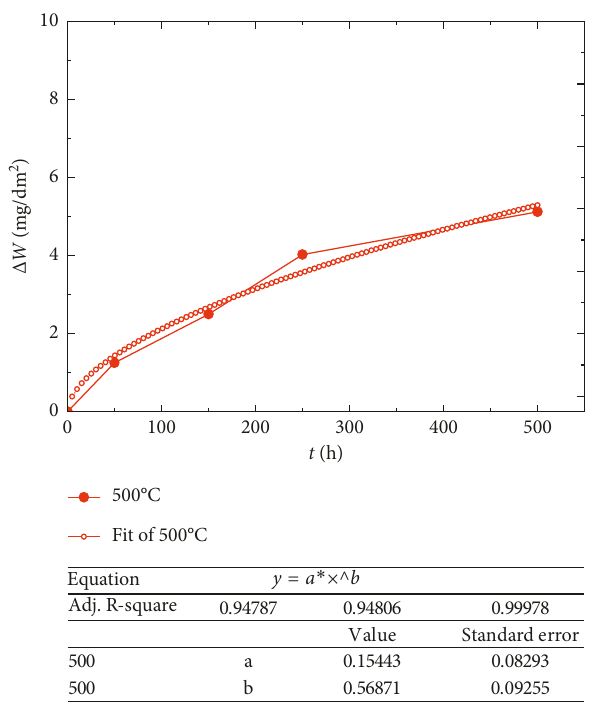
Figure 2: Weight gain as a function of time for C-276 exposed to